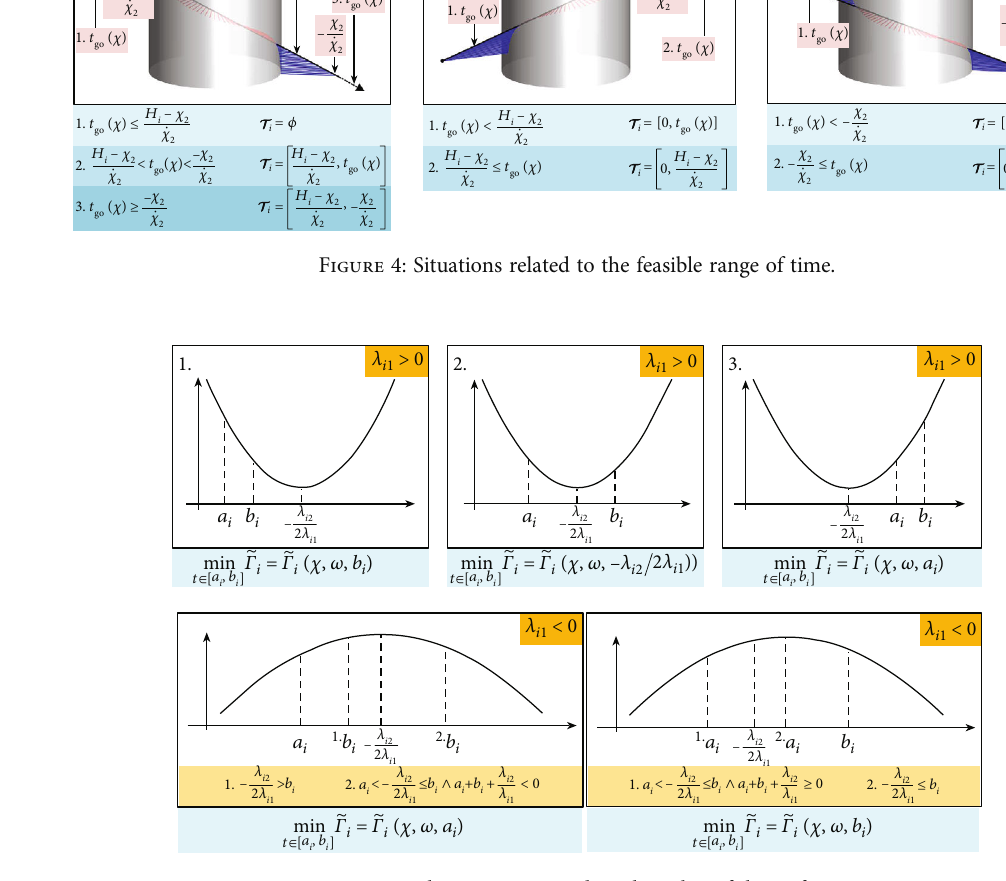
Figure 5: Several situations regarding the value of threat